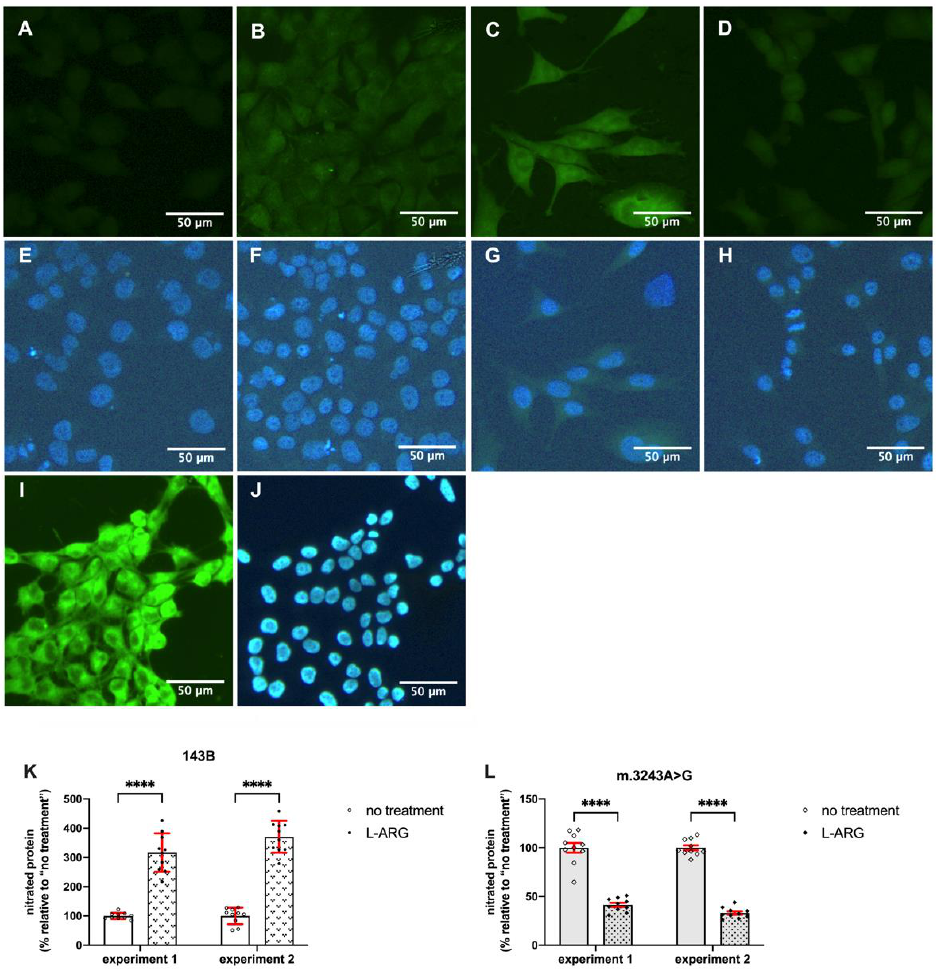
Figure 5. Nitrated proteins by immunostaining showed opposite effects of L-ARG in MELAS and control cells. Immunostaining was performed on 143B ( A , B , E , F ), m.3243A>G cells ( C , D , G , H ) and a positive control ( I , J ). Cells received no treatment ( A , C ) or L-ARG ( B , C ). Nitrated proteins were detected with the anti-3-Nitro-tyrosine antibody ( A – D , I ) nuclei were stained with Hoechst dye ( E – H , J ). The panel shows that immunostaining is low in 143B cells ( A ) but increased after L-ARG ( B ). m.3243A>G cells show evident staining ( C ), which was reduced with L-ARG. Immunostaining was quantified by image analysis ( K , L ) in two independent experiments. Dots represent the measured immunostaining in each cell and expressed as the percentage of the “no treatment” mean. Open dots are from no treatment and closed dots are from cells treated with L-ARG. A total of ten cells were quantified in each group. In both experiments, the results show an increase in nitrated proteins in 143B cells after L-ARG treatment ( A ). L-ARG induced an opposite result in m.3243A>G cells with a reduction in nitrated proteins ( B ). Statistical analysis was performed using two-way ANOVA followed by Bonferroni’s post hoc test., **** p < 0.0001.